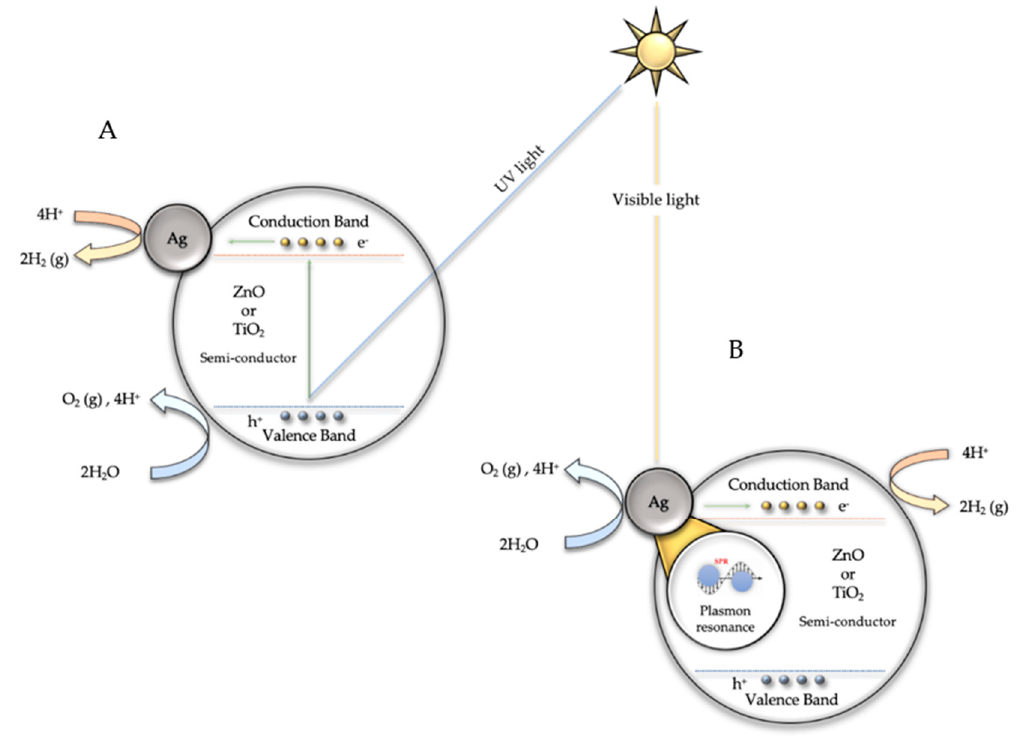
Figure 10. Mechanism for the production of hydrogen via water splitting using Ag@TiO 2 or Ag@ZnO catalysts under ultraviolet ( A ) and visible light ( B ).